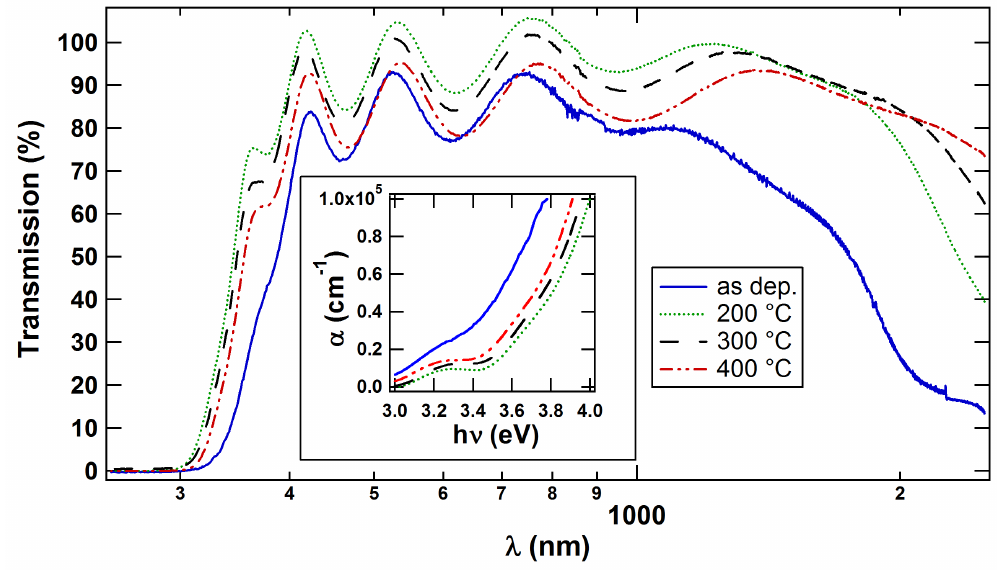
Figure 3. Transmission of In annealing for 2 h at different temperatures. Inset: corresponding absorption coefficient ( α ) at absorption